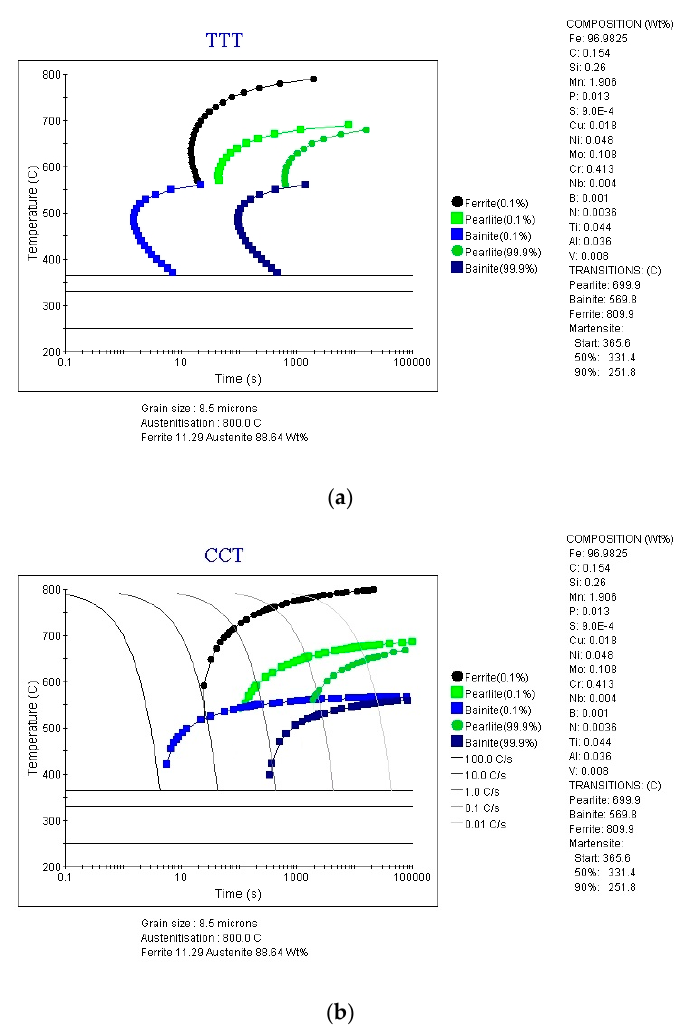
Figure 2. Calculated TTT ( a ) and CCT ( b ) diagrams for the steel investigated. The calculation was performed assuming a T IA = 800 °C.